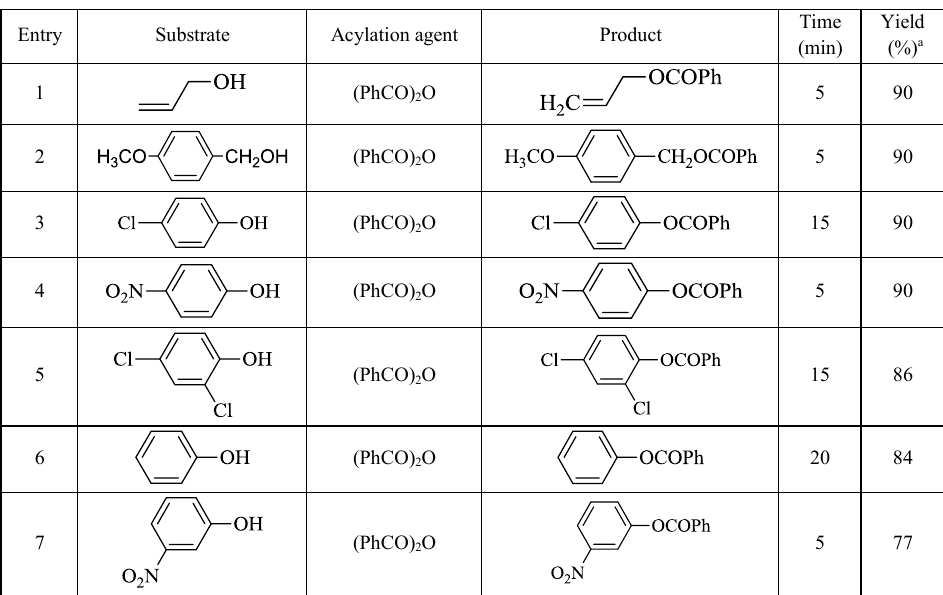
Table 1. Hydrotalcite catalyzed acylation of alcohols, phenols and thiols under solvent-free